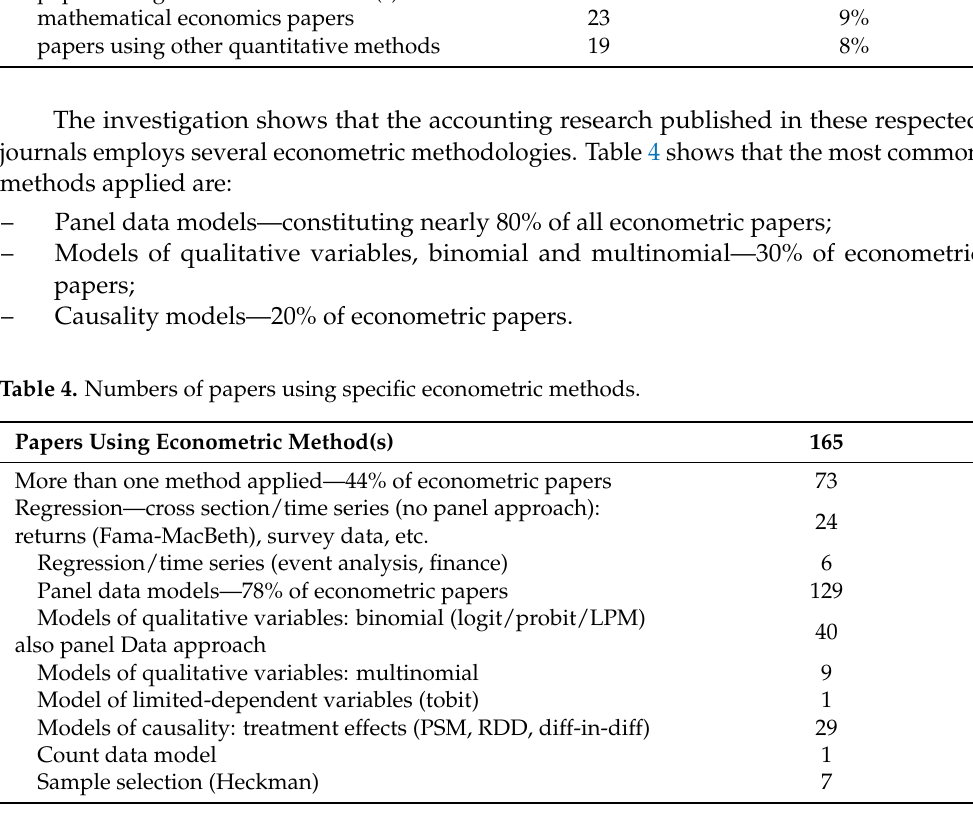
also panel Data